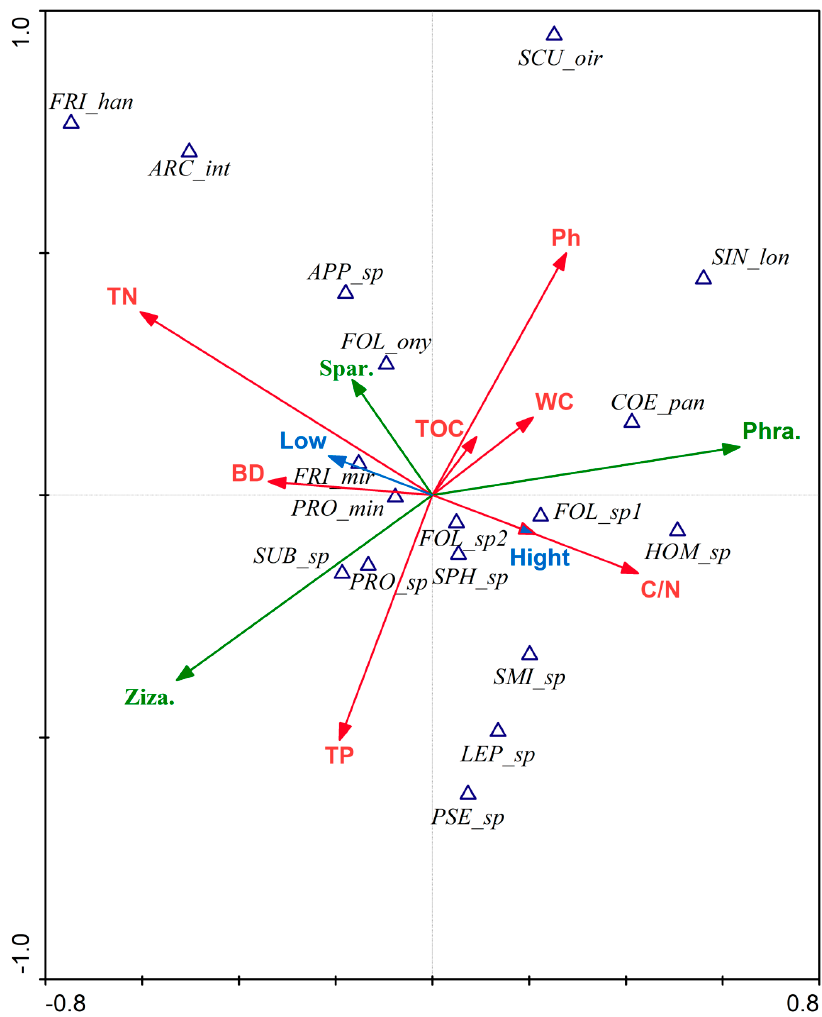
Figure 4. Parameter ordination of the environmental factor-species canonical correlation analysis. Triangle: species. Blue arrow: tidal flat, high tidal flat (High), and low tidal flat (Low). Green arrow: plants, Zizania latifolia (Ziza.), Phragmites australis (Phra.), and Spartina alterniflora (Spar.). Red arrow: physicochemical properties, water content (WC), bulk density (BD), power of hydrogen (Ph), total nitrogen (TN), total phosphorus (TP), total organic carbon (TOC), and carbon-nitrogen ratio (C/N).